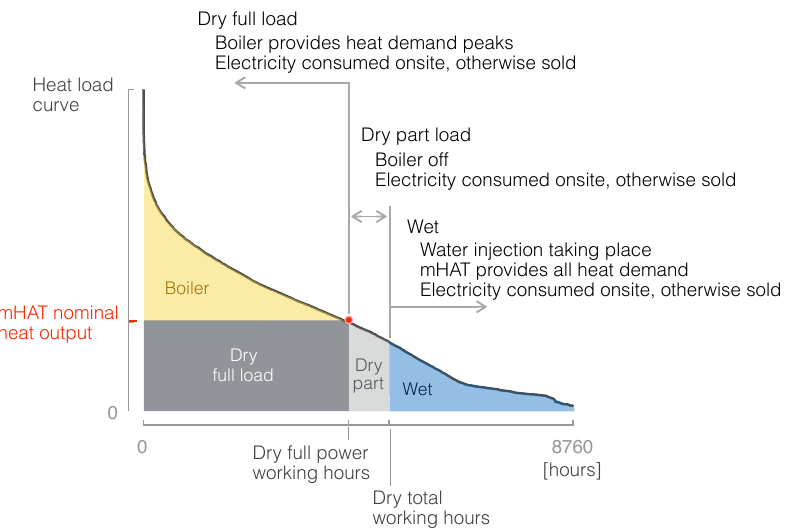
Figure 6. The flexibility of mHAT units allows them to operate all year long whatever the heat demand. The mHAT cycle runs in the mode that delivers the highest electrical